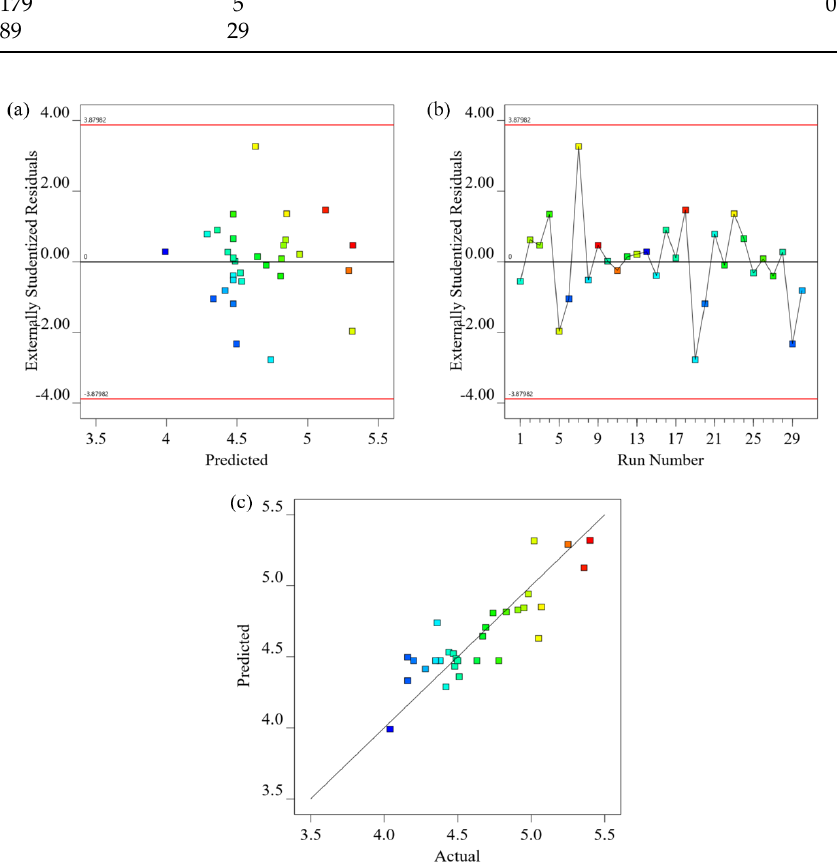
Figure 4. Model prediction analysis diagram. ( a ) Residuals and prediction diagrams; ( b ) graph of residual and number of experiments; ( c ) relationship between predicted and actual values.